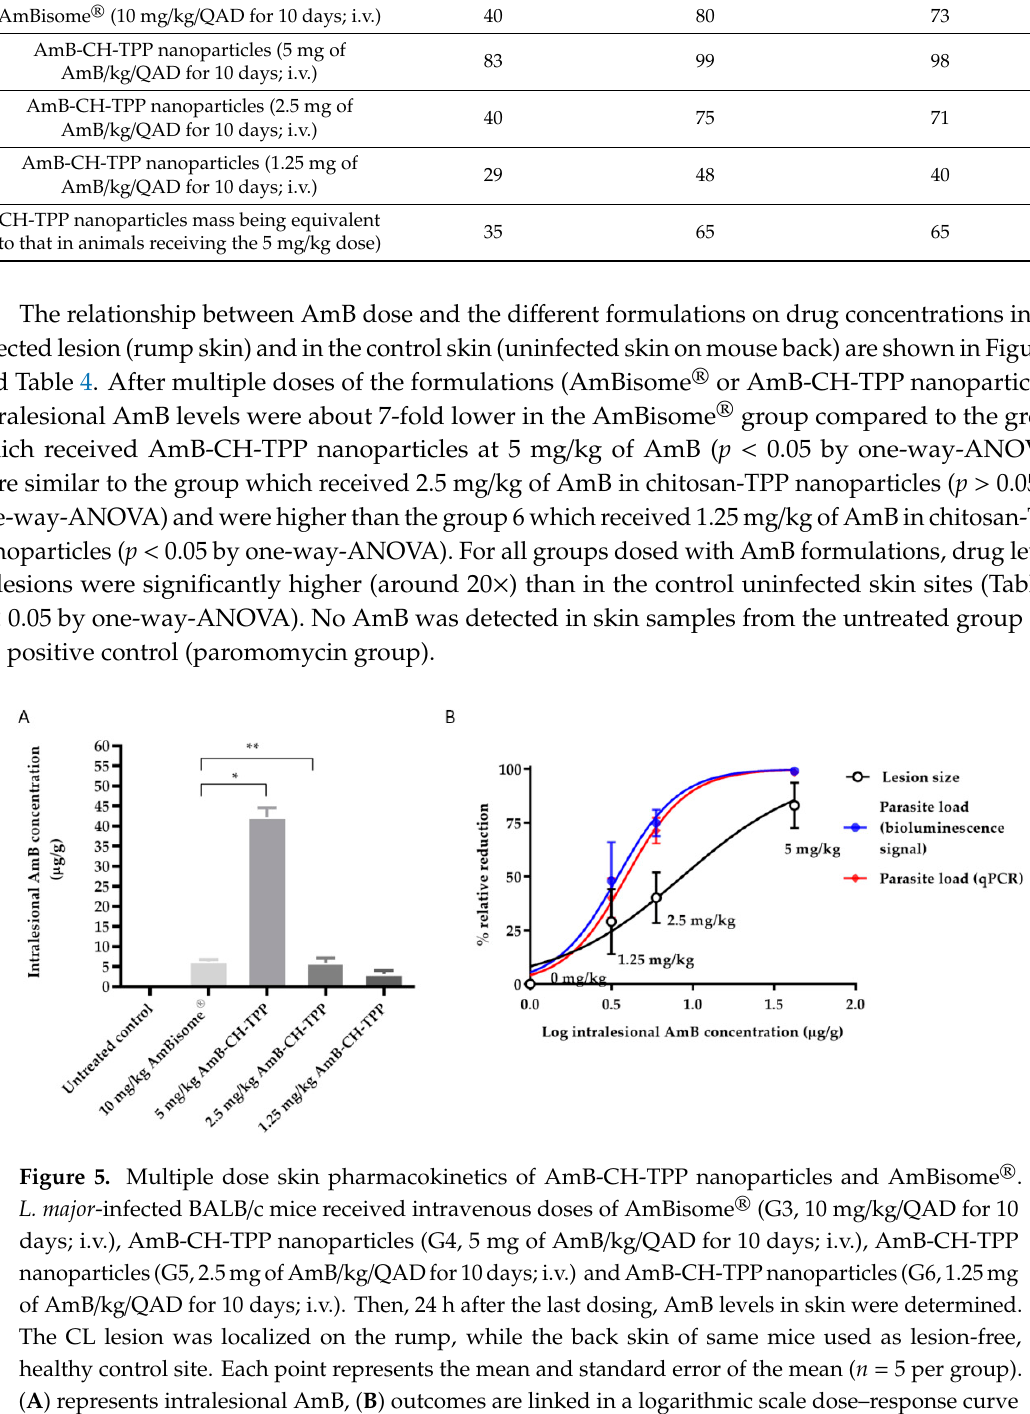
Table 4. A comparison between infected and uninfected skin AmB concentration in the lesion cure model in BALB/c mice infected with L. major . AmB Concentration μ g/g AmBisome ® (10 mg/kg/QAD for 10 days)